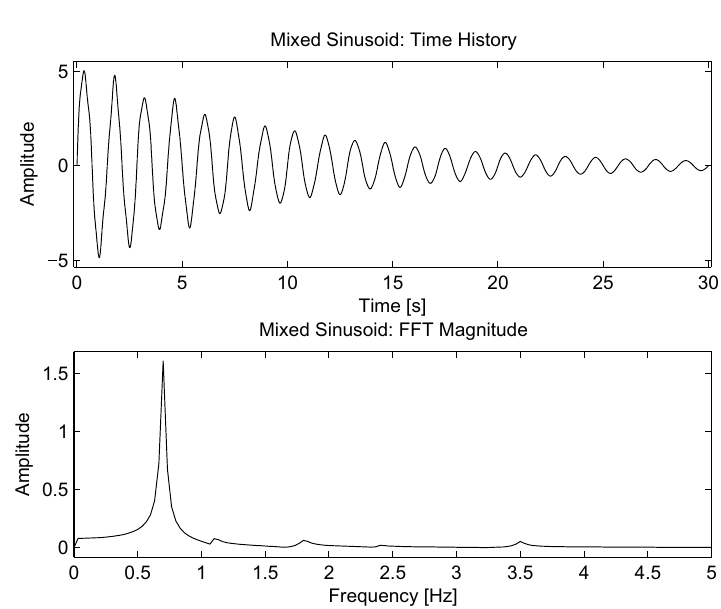
Fig. 7. Mixed damped sinusoid (top) and FFT magnitude (bottom) – ku ex =